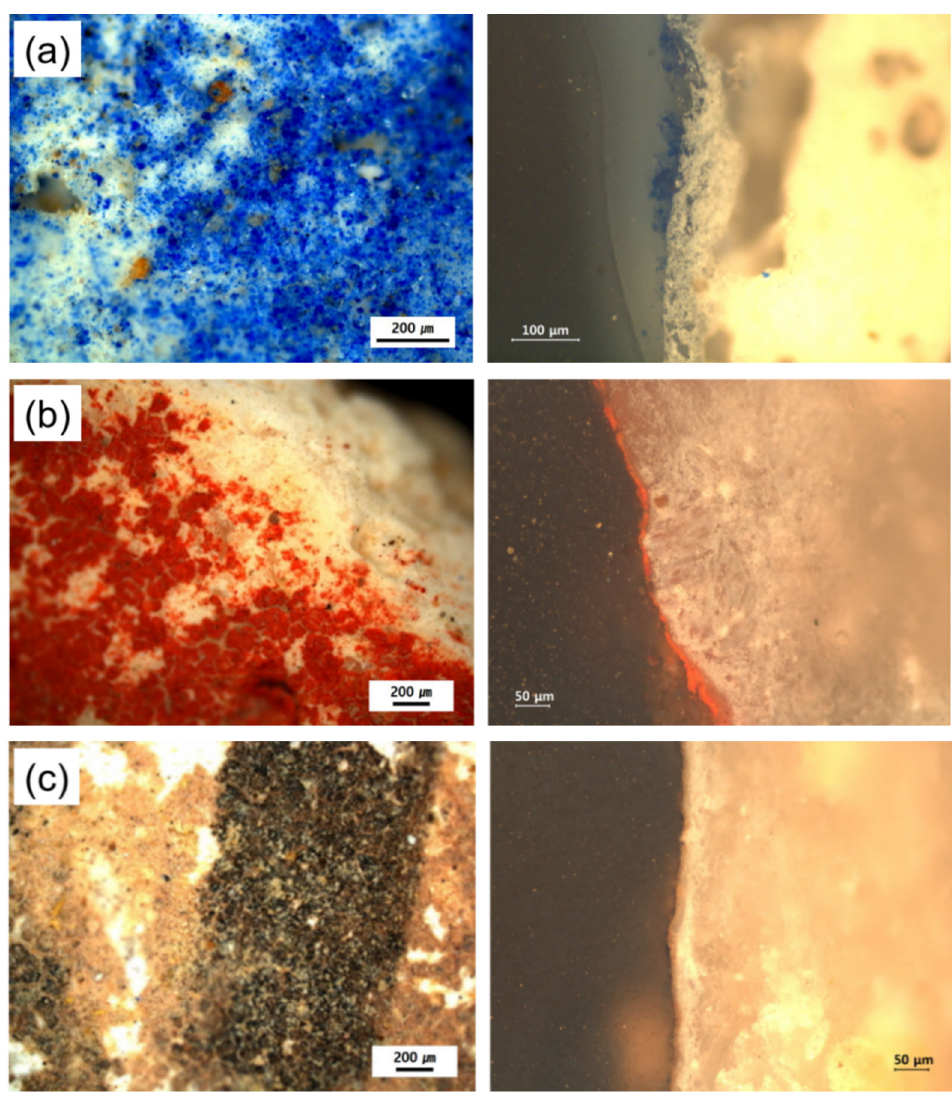
Figure 3. Surface and cross-sectional optical micrographs of ( a ) blue, ( b ) red, and ( c ) black pigment layers.